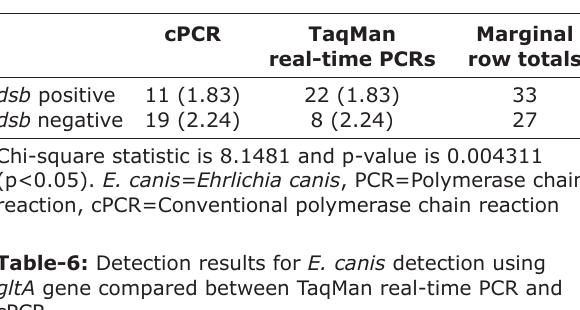
Table-5: Detection results for E. canis detection using dsb gene compared between TaqMan real-time PCR and cPCR.